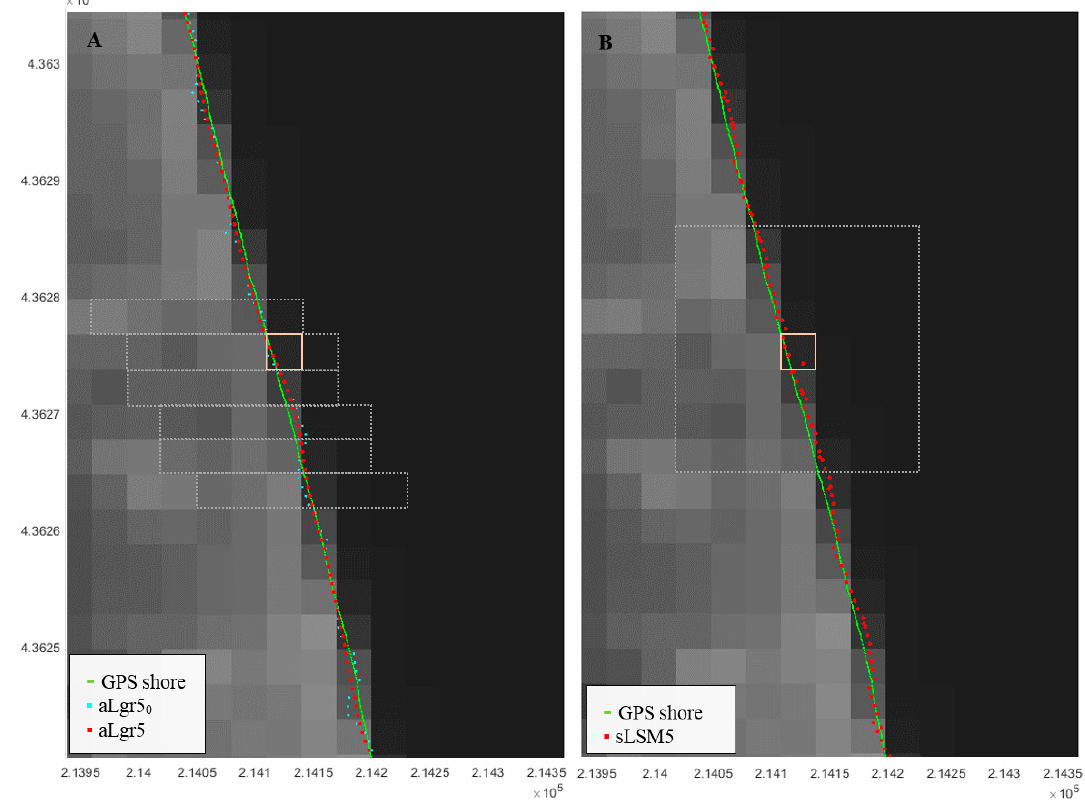
Figure 7. Sub-pixel shoreline obtained using various methodologies (described next in Table 2) on the 8 October 2016 at El Saler beach and compared with the true shoreline measured by GPS. ( A ) shows the sub-pixel shoreline solution obtained using successive adaptive windows around each initial shoreline pixel; while ( B ) uses fixed and symmetrical windows to make the adjustment. (A) also maps an unfinished solution (prior to the smoothening step; aLgr5 0 ) that illustrates the curvature effect produced by working with non-centred windows. As an example, a particular adaptive window in (A) and fixed in (B) are bounded in white and both pertain to the initial pixel highlighted in pink. The grid coordinates are: GCS_ETRS89 UTM31N (for an interpretation of the colour references in this figure legend, the reader is referred to the web version of this